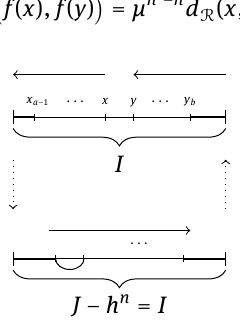
Figure 4: The modified itinerary, which stays in I